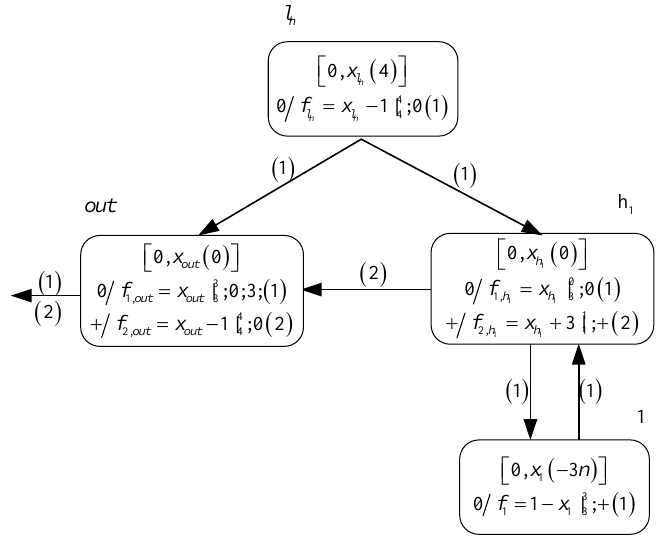
Π . Figure 5. The FIN module in system Π 1 1